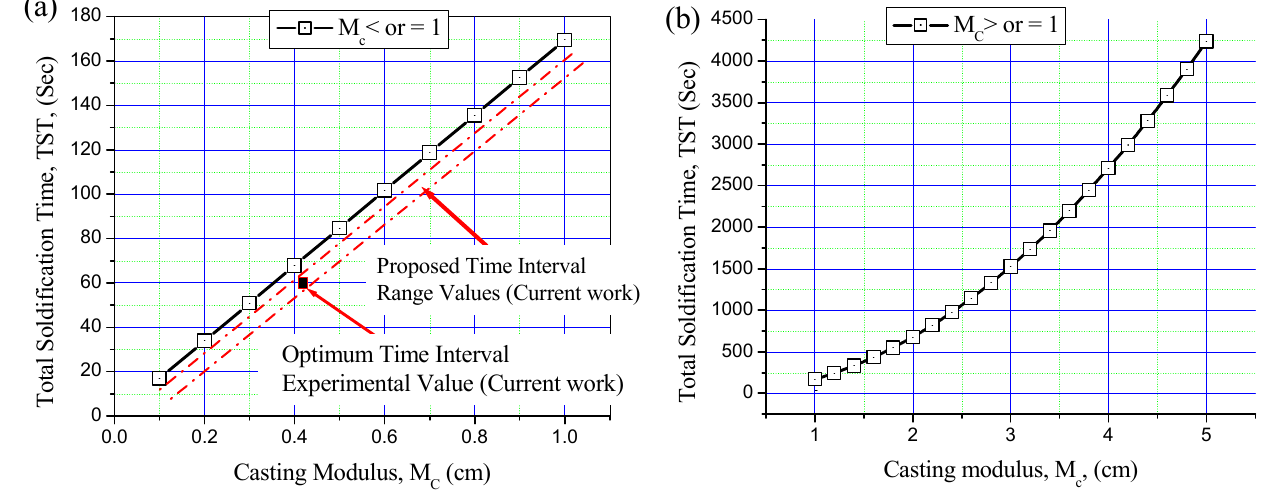
Figure 7. Total solidification time (TST) of Al-7.5Si alloy in sand mould for castings with different casting moduli: ( a ) M c ≤ 1 and ( b ) M c ≥ 1. Areas between the two red dotted lines represent the proposed time interval range values.